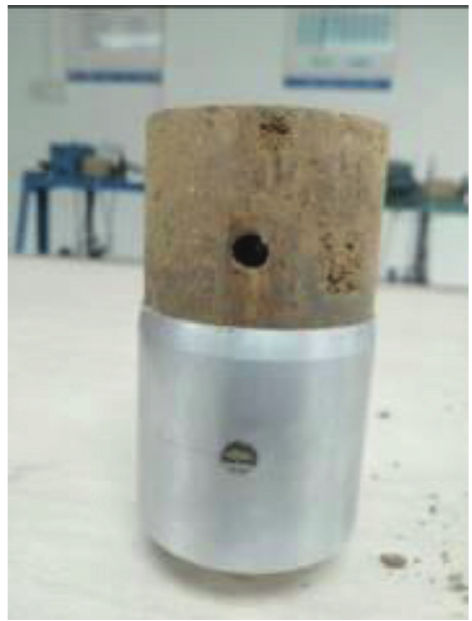
Figure 2: Schematic diagram of the ring knife and soil sample.